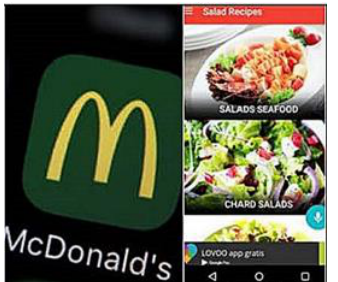
Figure 6. Mobile food apps (photograph submitted by family).